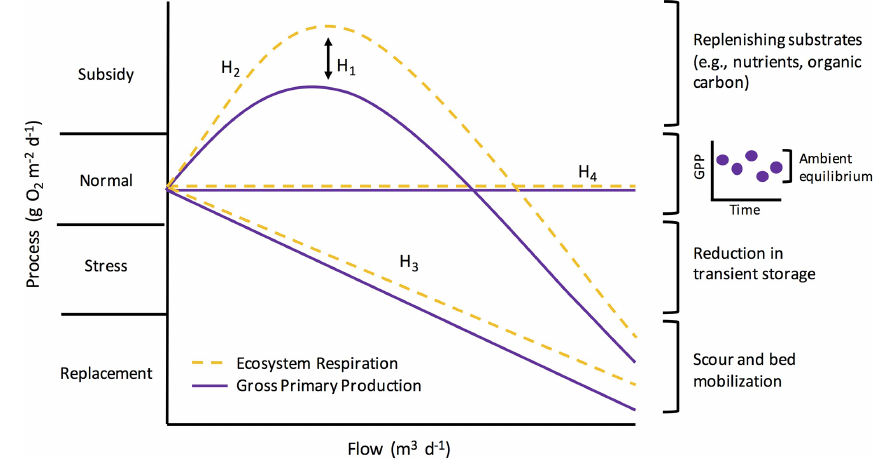
Figure 1. Potential metabolic responses along a subsidy–stress gradient of stream flow (adopted from Odum et al., 1979). Flow is on the x axis. The y axis represents ecosystem metabolism (i.e., gross primary production and ecosystem respiration; GPP and ER), scaled to the same “normal” starting values for comparison, and is broken into four categories as proposed by Odum et al. (1979): (1) subsidy (when flow replenishes carbon and nutrients and metabolism increases), (2) normal (periods of dynamic equilibrium under ambient flow), (3) stress (when ecosystem processes are suppressed by disturbance), and (4) replacement (when there is a severe reduction in metabolism and communities are scoured or replaced). H 1 – H 4 labels correspond to different hypotheses about how GPP and ER may respond differently to flow ( H 1 ) and how metabolism might change with flow ( H 2 – H 4 ), and they are described further in the main text of the “Introduction”. The inset graph next to the “normal” bracket depicts how ambient process rates are best represented by a dynamic ambient equilibrium rather than a fixed point of stability (sensu Odum et al.,